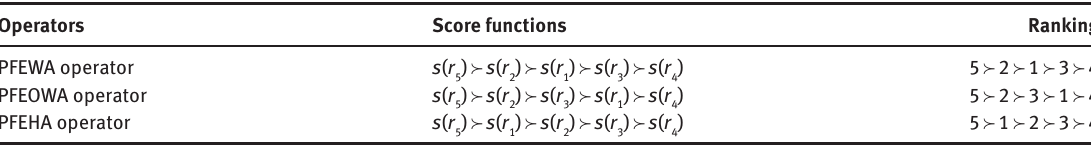
Table 11: Comparisons with Previous